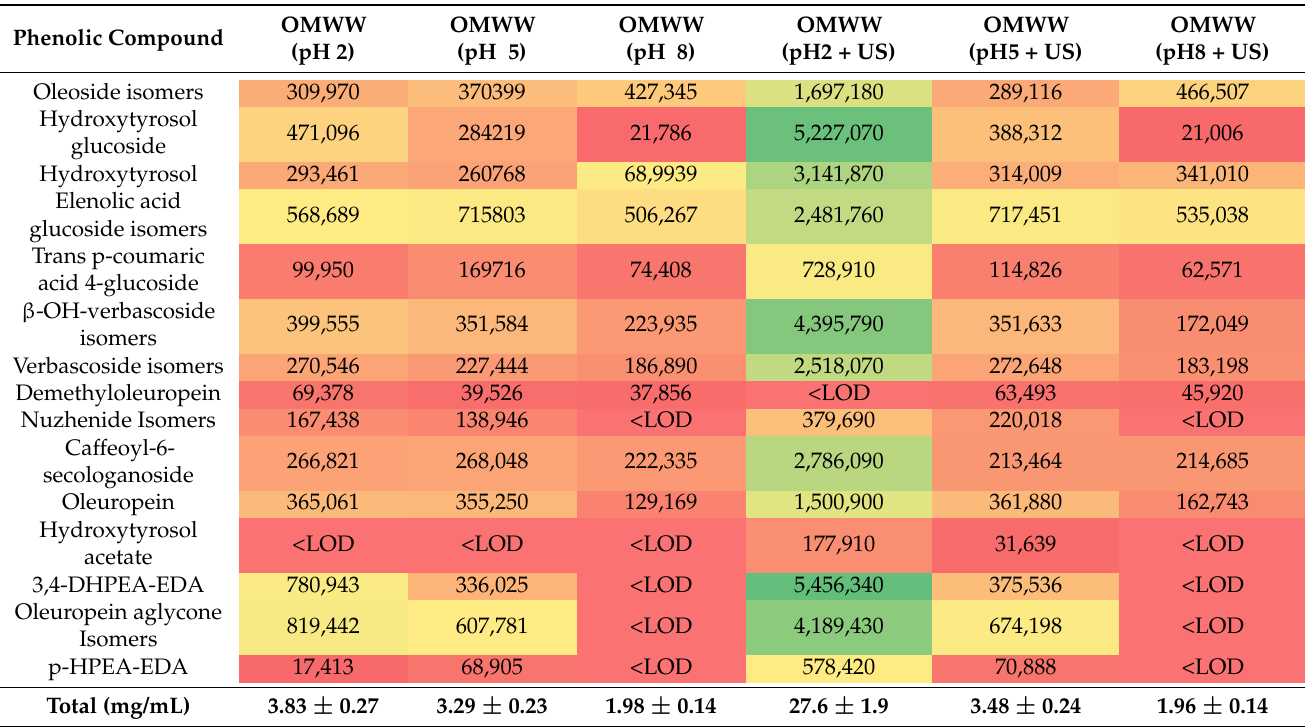
Table 2. Comparison between different OMWW treatment techniques using pH change and ultrasonication (40 min) to determine the polyphenol content. Total concentrations are in mg/mL, individual phenolic compounds are semi-quantified (counts on the MS